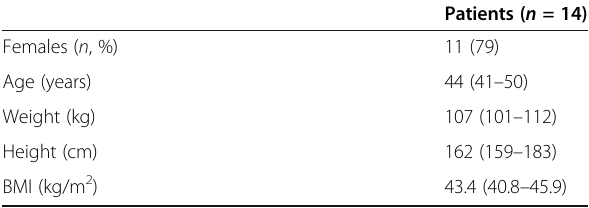
Table 1 Population